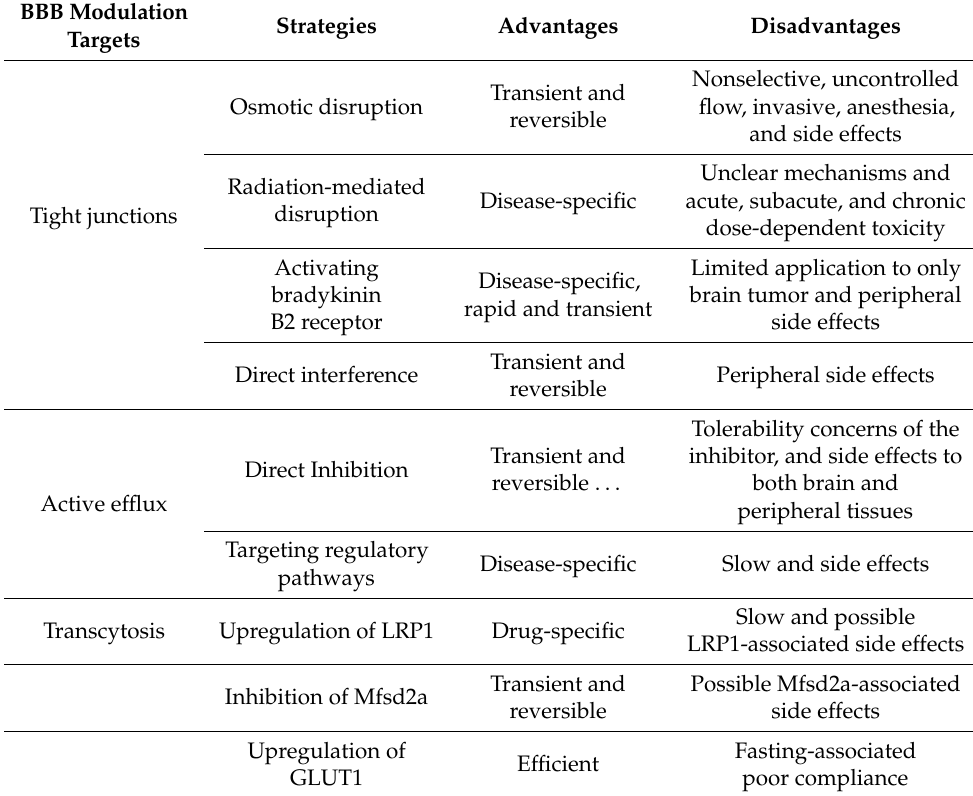
Table 1. BBB regulation strategies and related advantages and disadvantages.